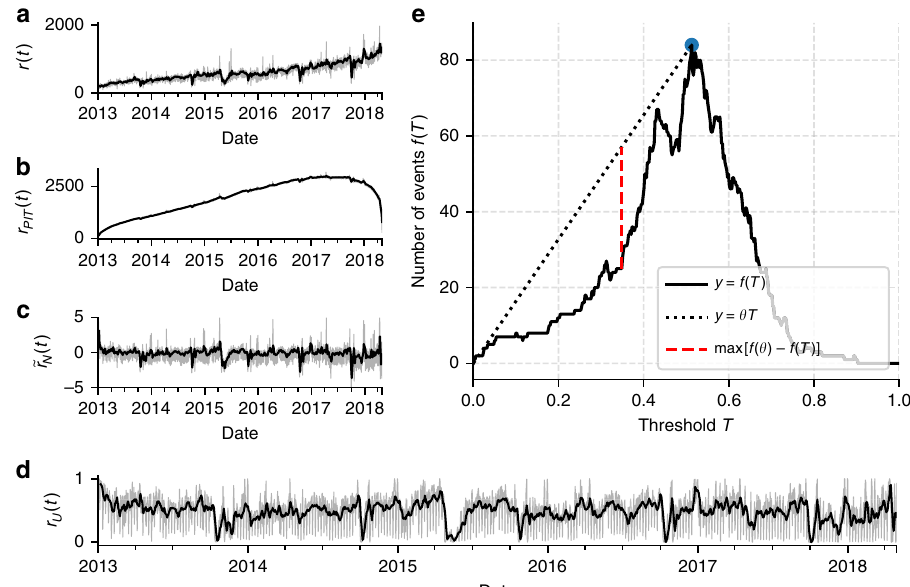
Fig. 3 Steps of the methodology to estimate the downtime of small businesses applied to Kathmandu, Nepal. a Time series of the total number of posts of all businesses ( r ð t Þ ), shown with weekly rolling mean (black solid line). b Single business Probability Integral Transformed data ( r PIT ). c Data is shifted and rescaled according the number of active businesses. d PIT applied on the aggregated and transformed time series. e Downtime detection using the elbow method.